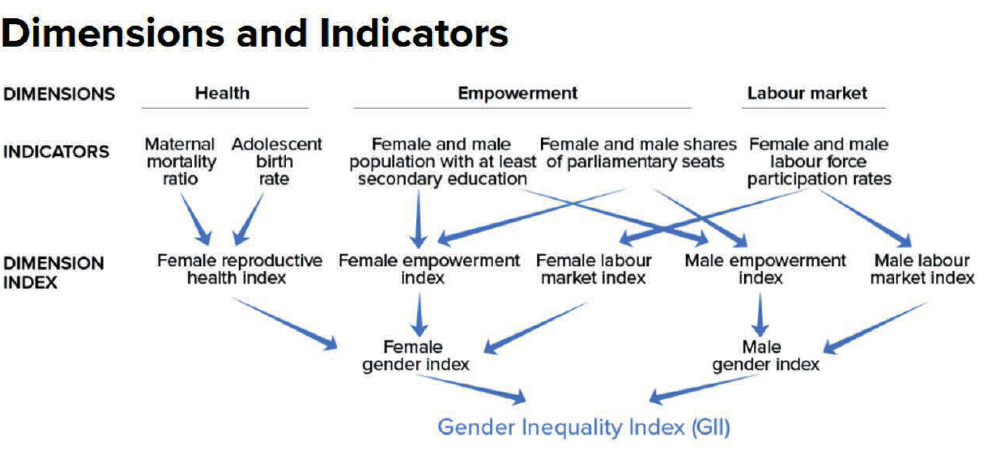
Fig. 1. Gender inequality index (WHO,